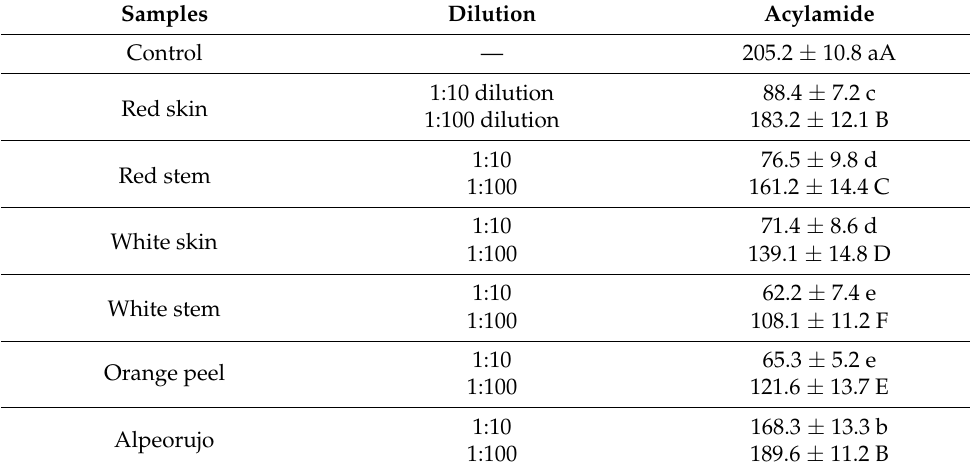
Table 1. Acrylamide concentration (ng g − 1 ) of ‘Manzanilla Cacereña’ table olive variety after the addition of different agro-industrial by-products. Different lowercase letters mean a statistically significant difference between by-product extracts (Tukey’s test p < 0.05 n = 3). Different capital letters mean significant differences between the different dilutions (Tukey’s test p < 0.05 n =